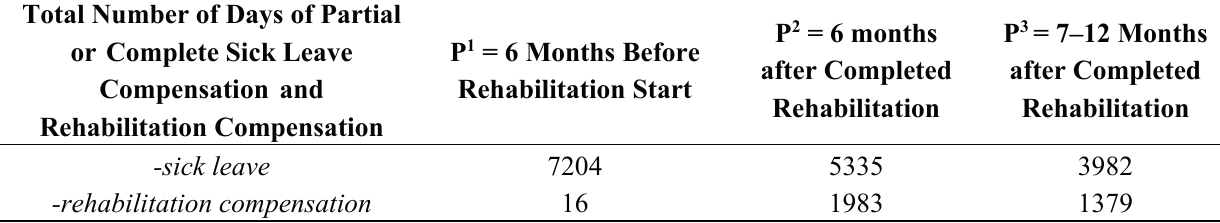
Table 6. The total number of days with sickness and rehabilitation compensation (partial or full) for participants in the NBR group ( n = 44) during P1 1 , P2 2 , and P3 3 . Total Number of Days of Partial or Complete Sick Leave